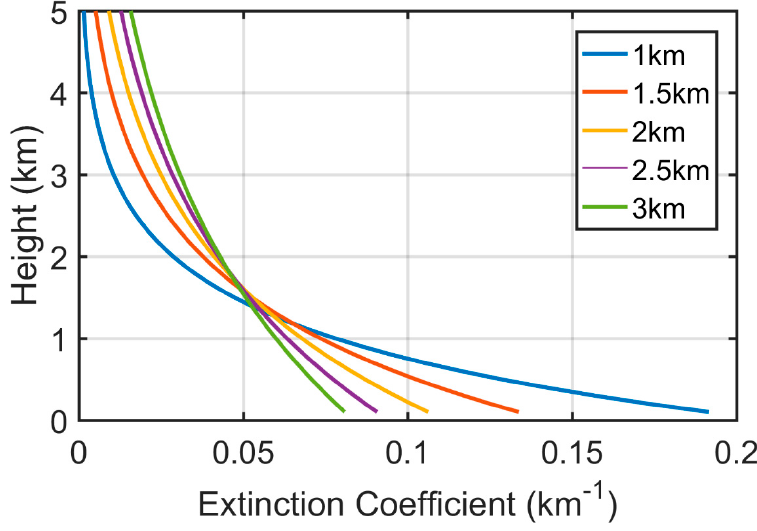
Figure 1. Examples of exponentially decreasing aerosol profiles for different scale heights, varying from 1.0 to 3.0 km with an interval of 0.5 km. Only profiles below 5 km are shown in this figure.